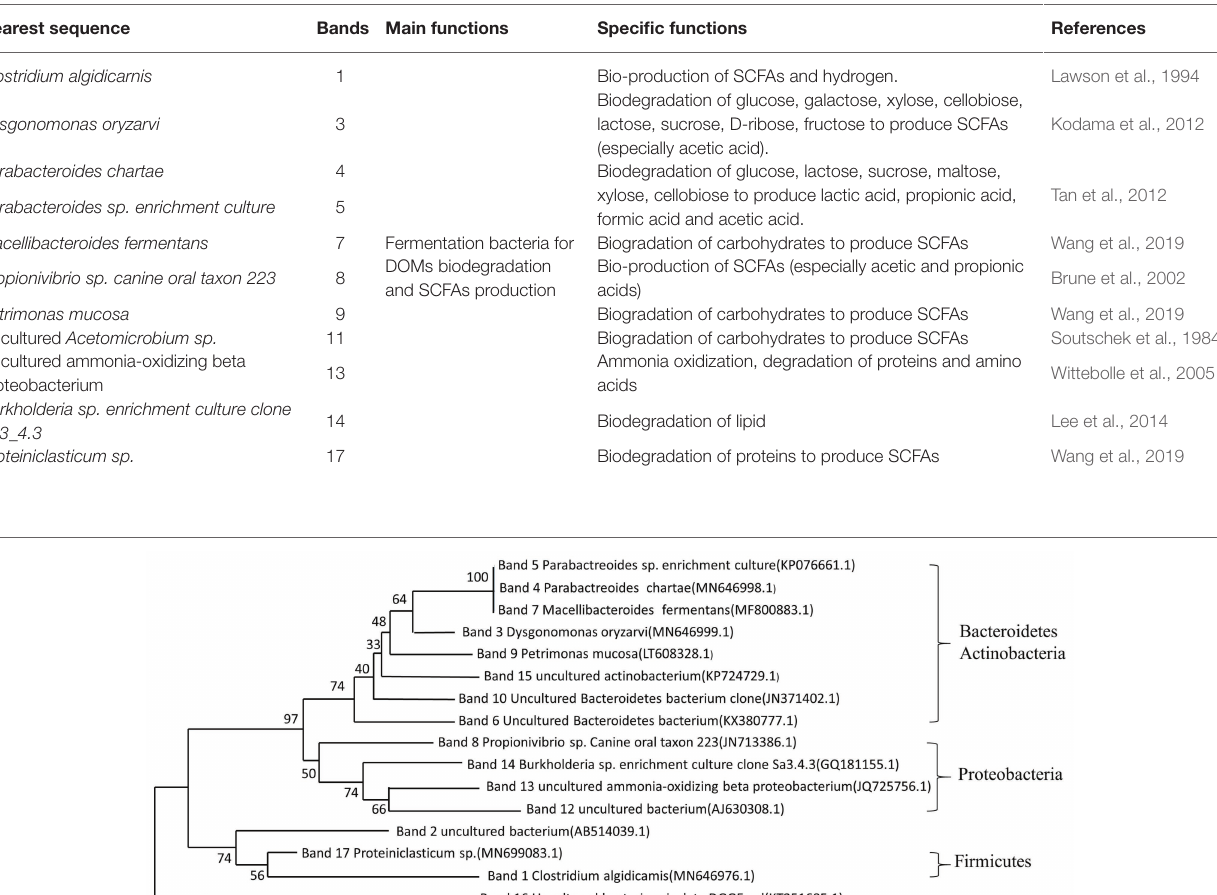
TABLE 2 | Main functions of the key bacteria.